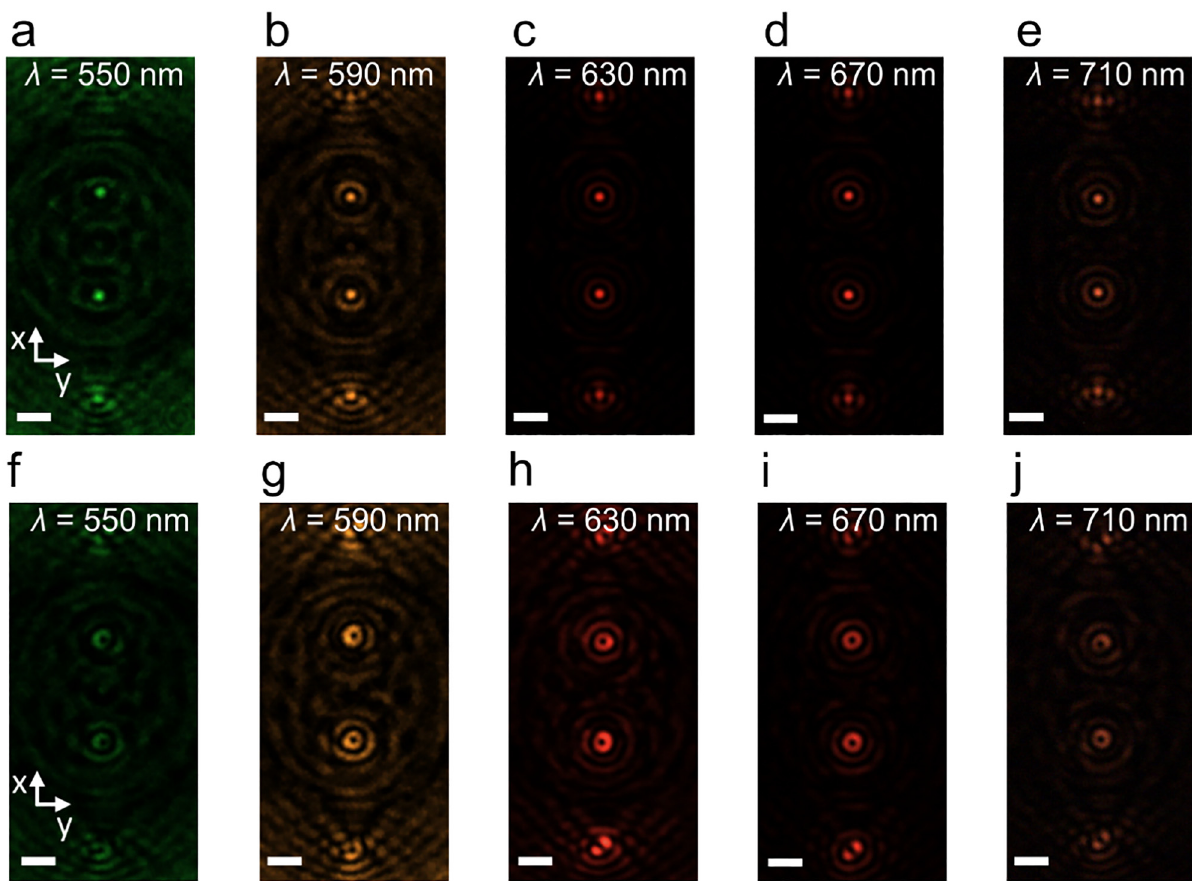
Figure 4: Measured transverse intensity distributions of J 0 (a – e) and J 1 (f – j) Bessel beam arrays at the vertical location of z = 90 μ m at wavelengths λ = 550, 590, 630, 670, and 710 nm,